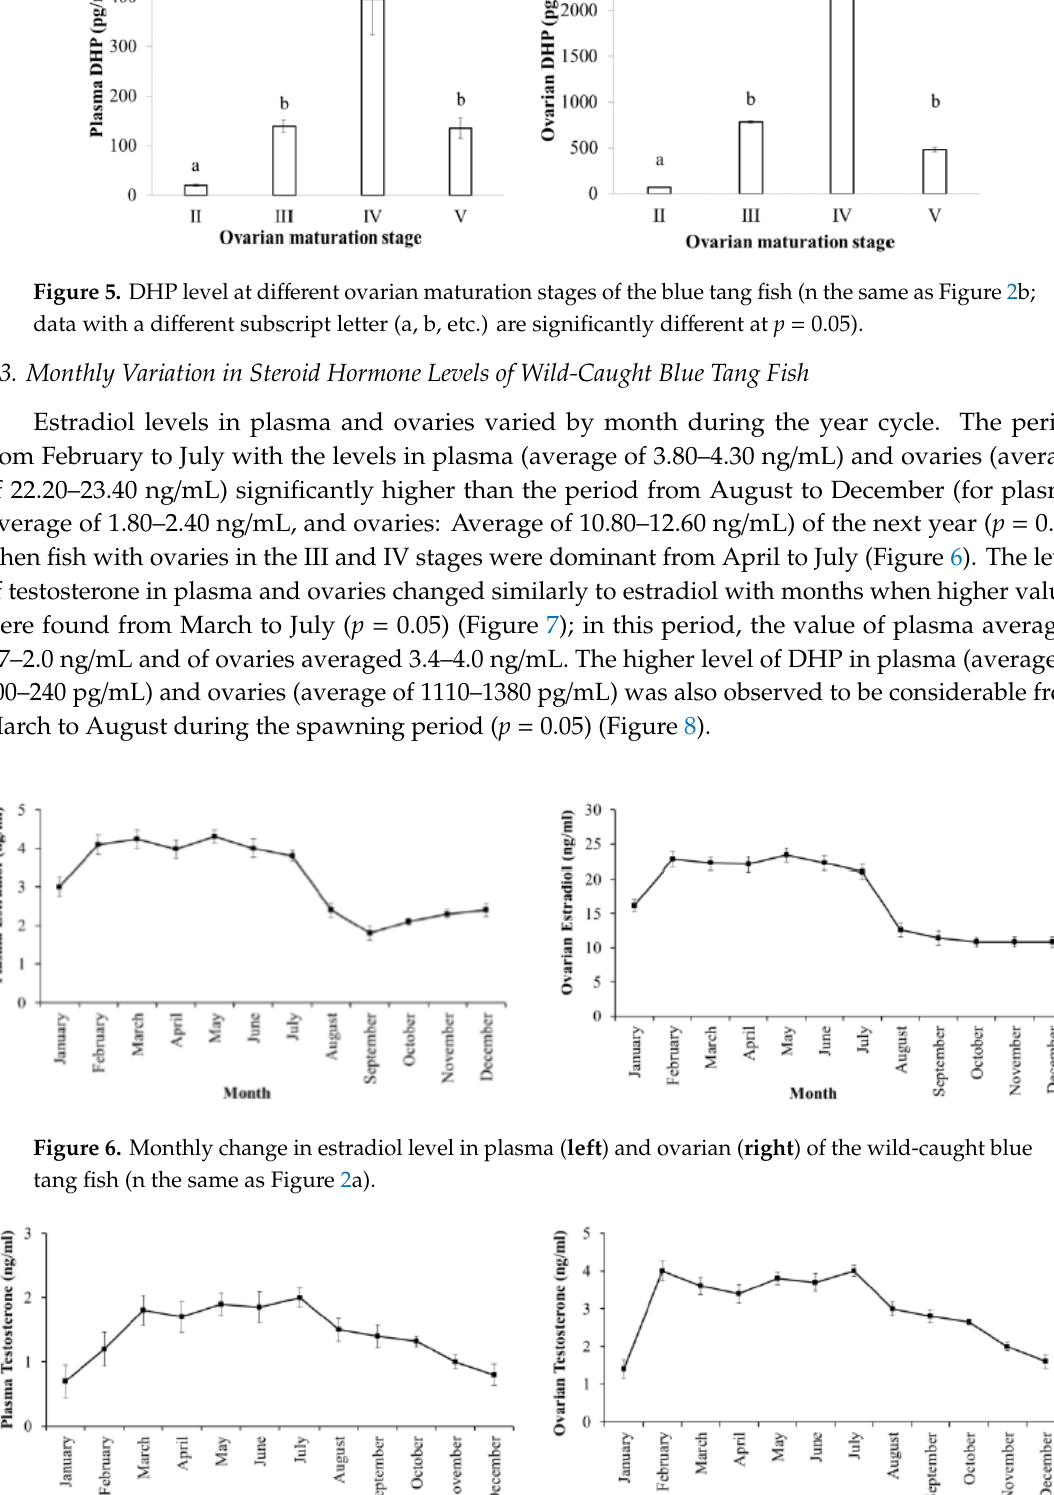
Figure 4. Testosterone level at different ovarian maturation stages of the blue tang fish (n the same as Figure 2b; data with a different subscript letter (a, b, etc.) are significantly different at p = 0.05).